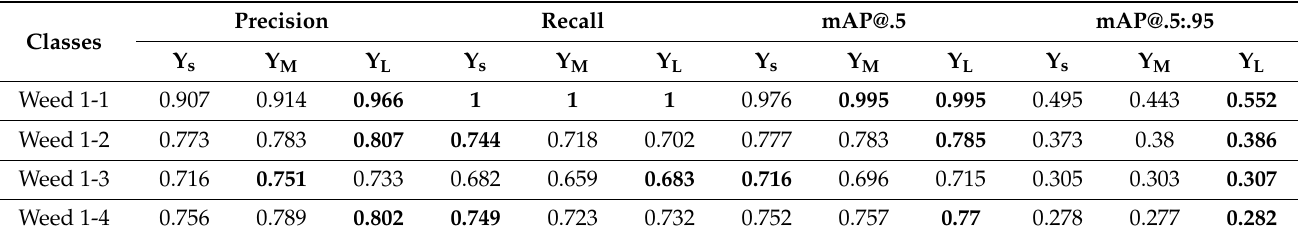
Table 6. Detecting weed growth stages using YOLOv5